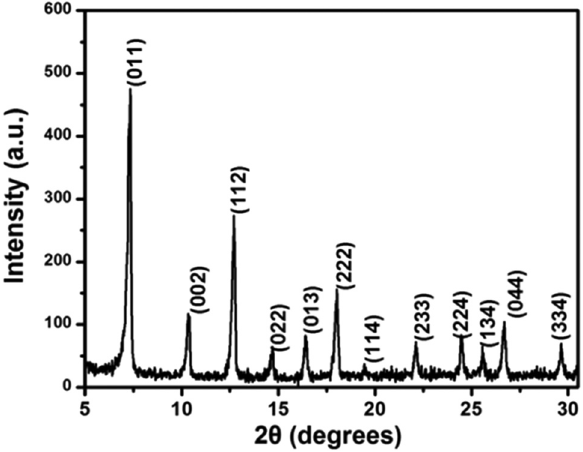
Figure A1: PXRD pattern of ZIF - 67 [ 58 ] .